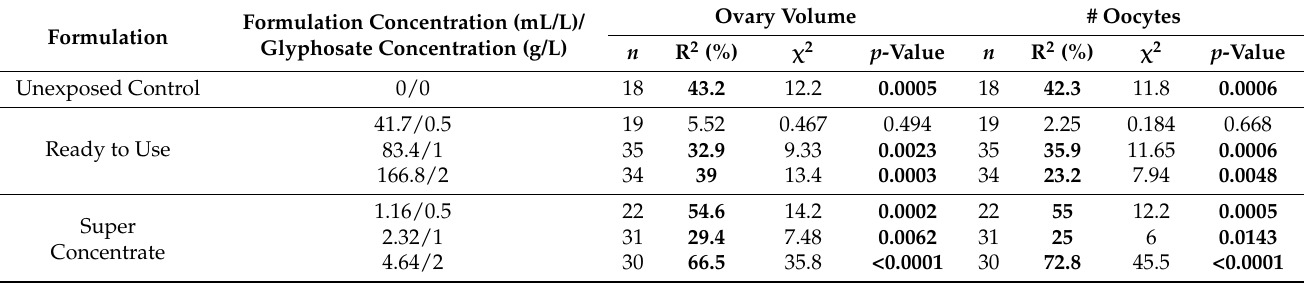
Table 4. Linear regression of ovary volume and number of oocytes on body size, by formulation and glyphosate concentra- tion. Regression coefficients (R 2 ) are only meaningful if p < 0.05, shown in bold.